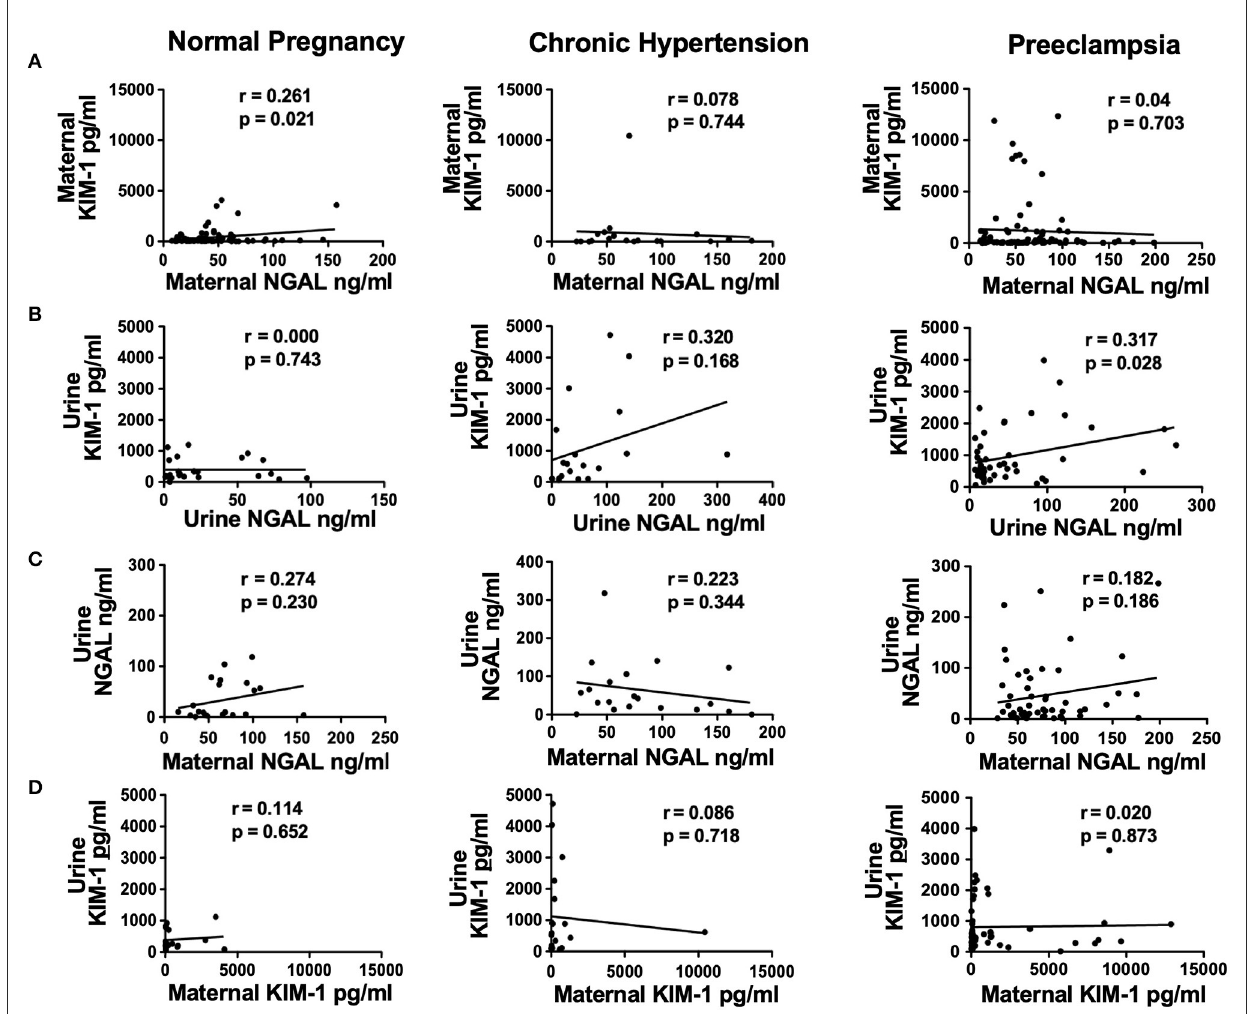
FIGURE1 Correlations of maternal plasma and urine levels of NGAL and KIM-1 in normal pregnant women, and in pregnant women complicated with chronic hypertension (CHT) or preeclampsia. (A) Correlation of maternal KIM-1 and maternal NGAL; (B) correlation of urine KIM-1 and urine NGAL; (C) correlation of urine NGAL and maternal NGAL; and (D) correlation of urine KIM-1 and maternal KIM-1,